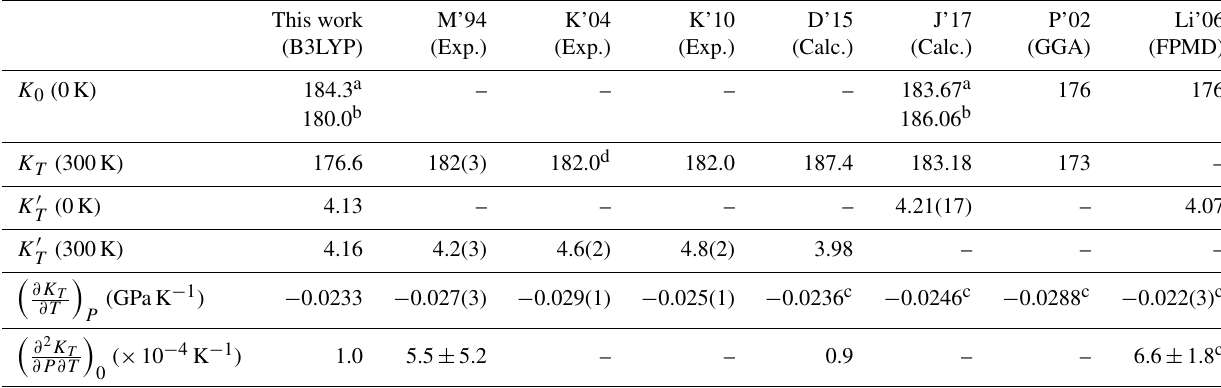
(cid:16) ∂ 2 K (cid:17) T is the mixed P – T derivative of K T ∂P∂T 0